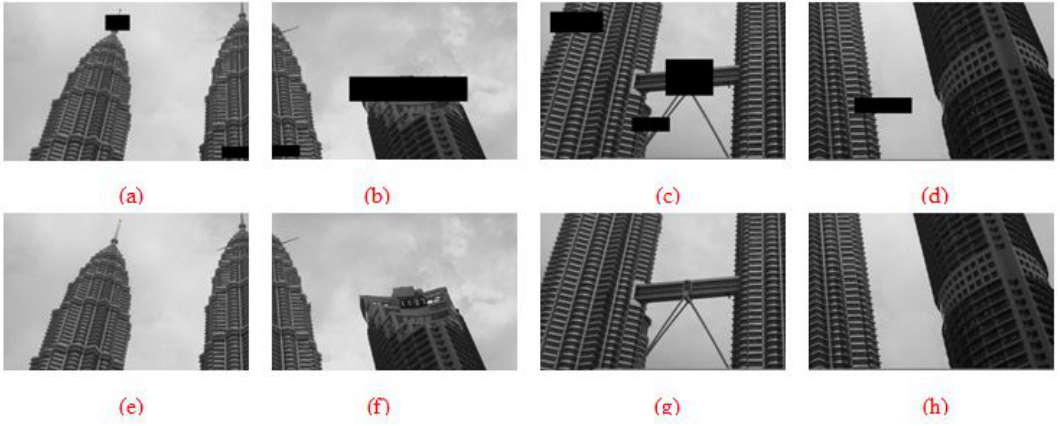
Fig. 7. (a) damage blocks in the 1 st quadrant of the image. (b) in the 2 nd quadrant, (c) in the 3 rd quadrant (d) in the 4 th quadrant, (e, f, g and h) is the progression in masking